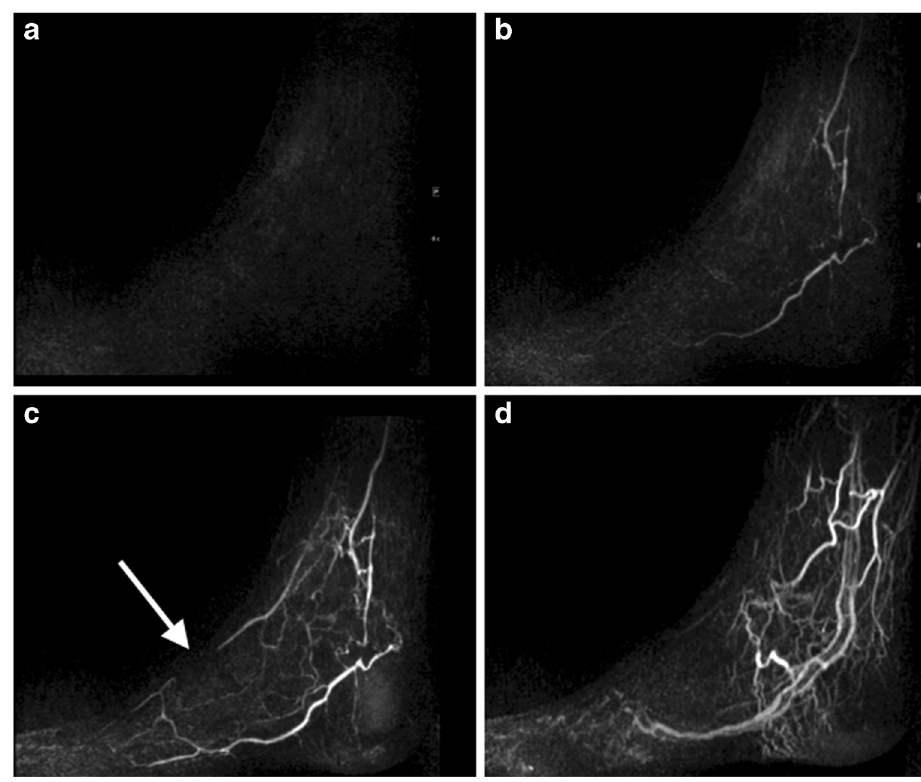
Fig. 15 Selected sagittal images from a time-resolved MRA of the left foot in a patient with diabetes and foot pain. The initial mask image ( a ) demonstrates only a vague outline of the foot, with subsequent enhancement of the arteries ( b, c ), followed by venous filling at a later time point ( d